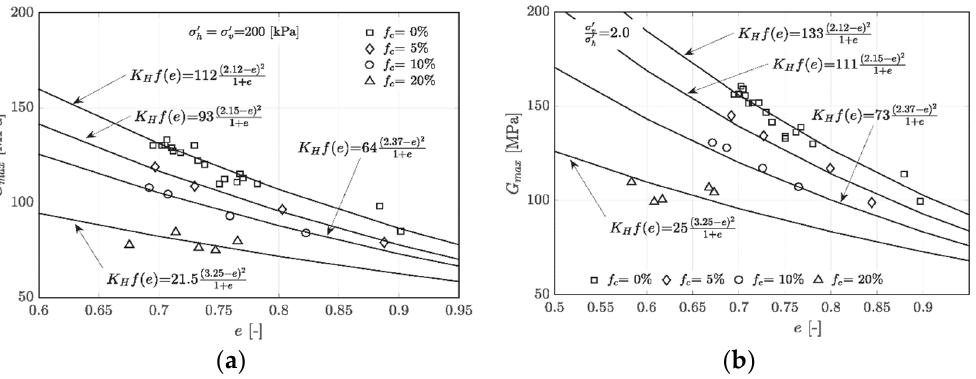
( b ) Figure 8. Variation of the G max with different void ratios and fines content under ( a ) isotropic and ( b ) anisotropic stress states. 4. Analysis of Results Using the popular models of [1] and [23], the variation in the G max with e , p’ and . /1 /. ℎ′ = 1 (isotropic) and 2 (anisotropic) was quantified as shown in Figure 9. In general, a good fit with the experimental data can be seen. Later, the G max was normalized with the void ratio function employing an average value of the fitting parameter c (= 2.12, 2.15, 2.37